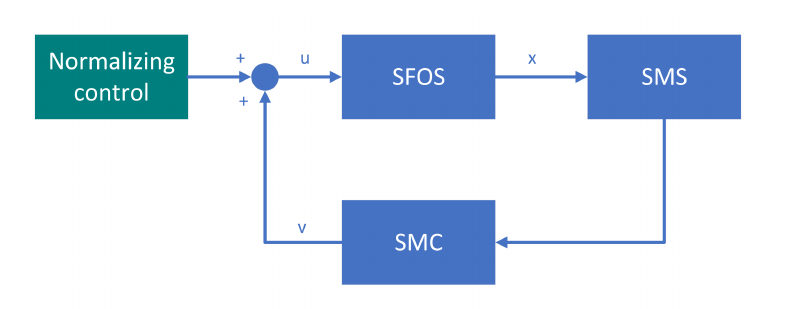
Figure 1. Block diagram of the control